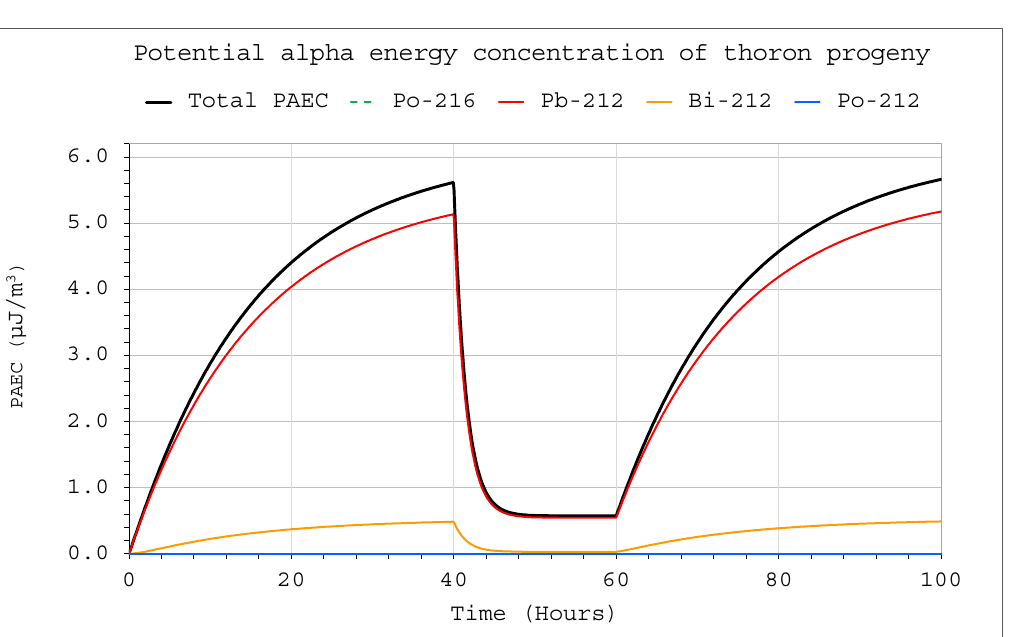
Figure 11. Potential alpha energy concentration of thoron progeny inside the system for the following conditions: inflow of thoron throughout the analyzed period at a rate of E 1 = 1 Bq/s, V = 20 m 3 , C oi = 0. The filtration system was operating in the range of 40–60 h with a flow rate of Q D = 10 L/min and a filtration efficiency of F = 100%.